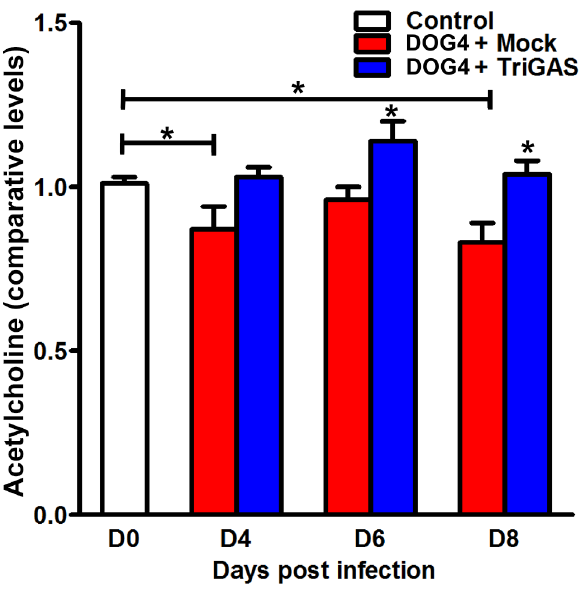
Figure 2. PET with TriGAS prevents the RABV infection- induced decline in acetylcholine. Mice were infected i.n. with 10 5 FFU of DOG4 and 4 hr later either mock treated i.m. with PBS or treated with 10 7 FFU of TriGAS. An additional group of uninfected, untreated mice served as a reference. Six mice per group were euthanized for each time point, and the levels of acetylcholine were determined via LC- GC/MS-MS2 as described in Materials and Methods. The results are presented as comparative levels ( + / 2 SE). Statistical differences between groups were analyzed using Welch’s two sample t test and are identified by *p , 0.05. The horizontal lines represent significant differences between control and DOG4-infected/mock-treated mice while the asterisks over bars represent differences between mock- and TriGAS –treated, infected mice.